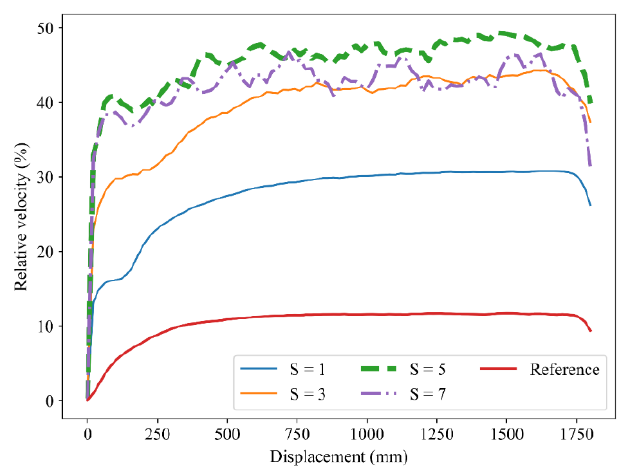
Figure 13. Relative velocity of the particles for the convex pattern surface.